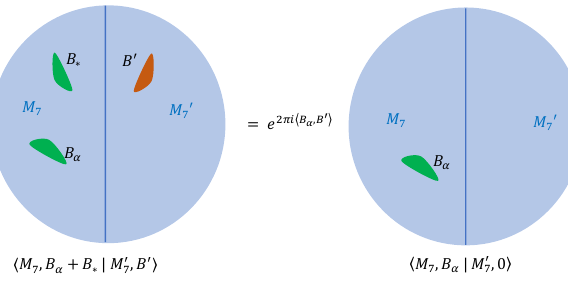
Figure 2 . 7d partition function from gluing 7 -manifolds with defects described by the Poincaré dual of B . Removing the pair B 0 , B together introduces a ∗